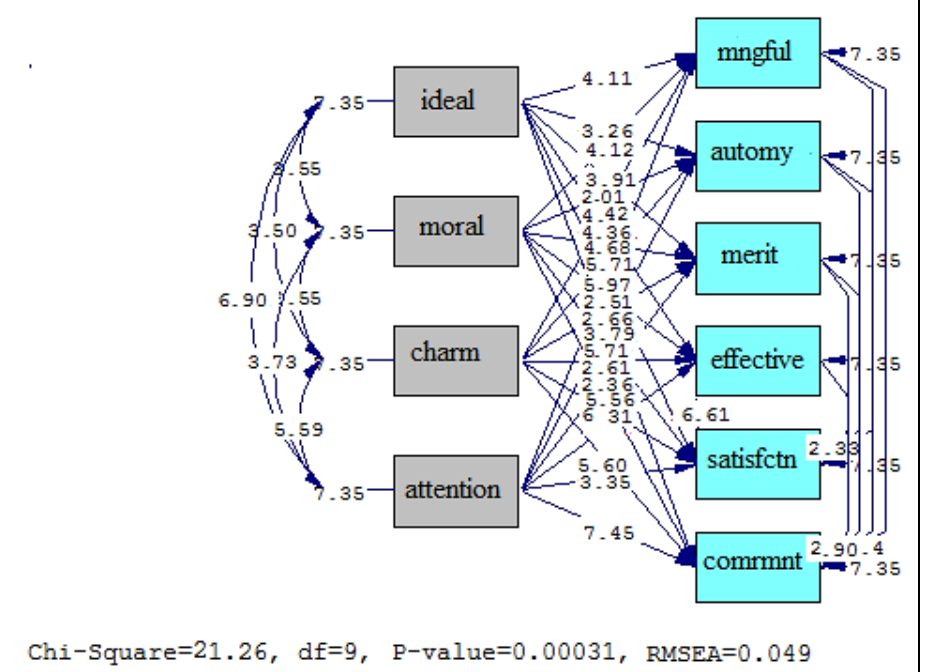
Figure 3. Structural equation model in meaningful mode